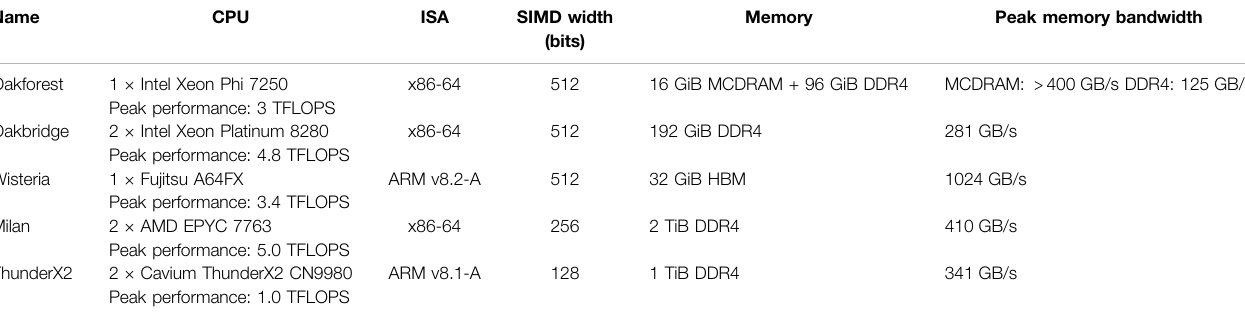
TABLE 2 | Hardware speci fi cations (compute node level) of the fi ve target platforms. ISA is an abbreviation of “ instruction set architecture ” .